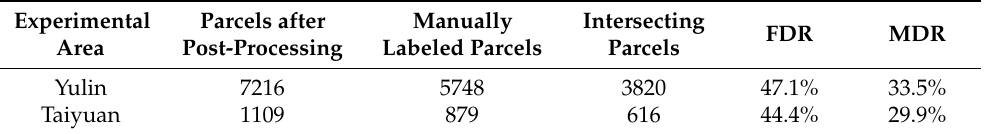
Table 4. Parcel accuracy after processing.